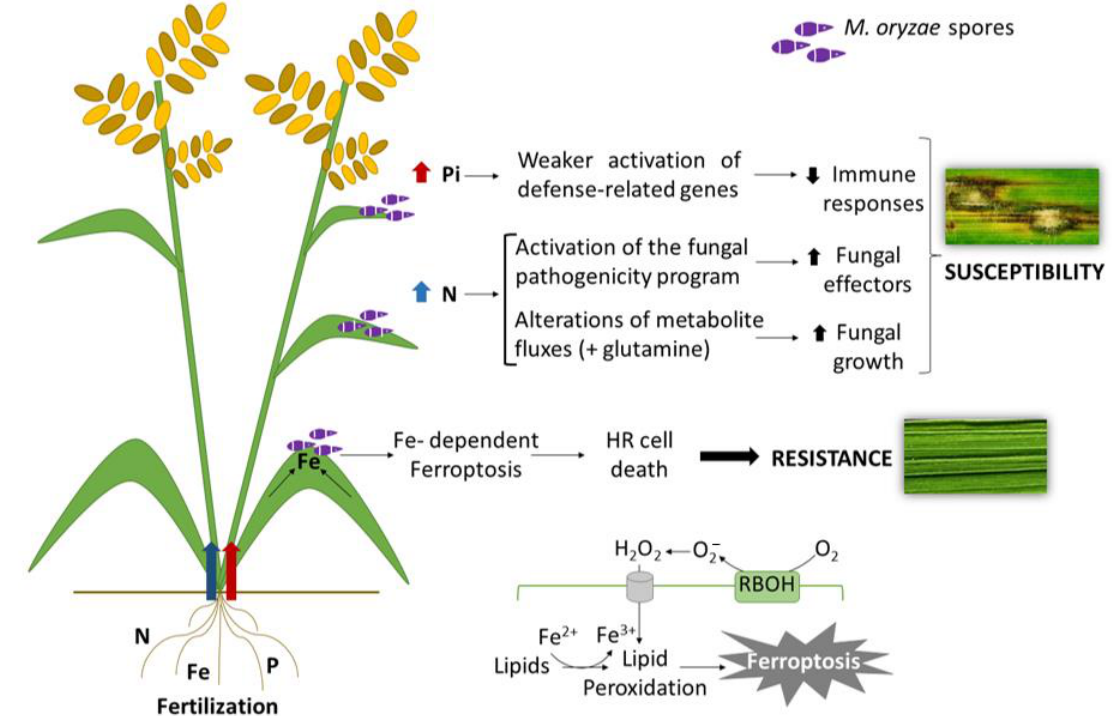
Figure 3. Crosstalk between nutrient signalling pathways and immune response. Nutrients are essential for plant growth and development. They are obtained from the soil through the plant root system. However, insufficient or excessive amounts of certain nutrients can affect disease resistance in plants. In rice, high nitrogen (N) supply not only promotes M. oryzae growth but also induces the expression of fungal effector genes, thus making the plant more susceptible to infection [117]. Growing rice plants under high phosphate (Pi) conditions leads to an increase in leaf Pi content, which is associated with a weaker activation of defence responses and susceptibility against the rice blast fungus [98]. Ferroptosis, an iron (Fe)- and ROS-dependent cell death process, contributes to arrest M. oryzae infection in incompatible rice/ M. oryzae interactions [120]. Thus, iron levels must be strictly controlled in the host plant to maintain the subtle balance between growth and defence